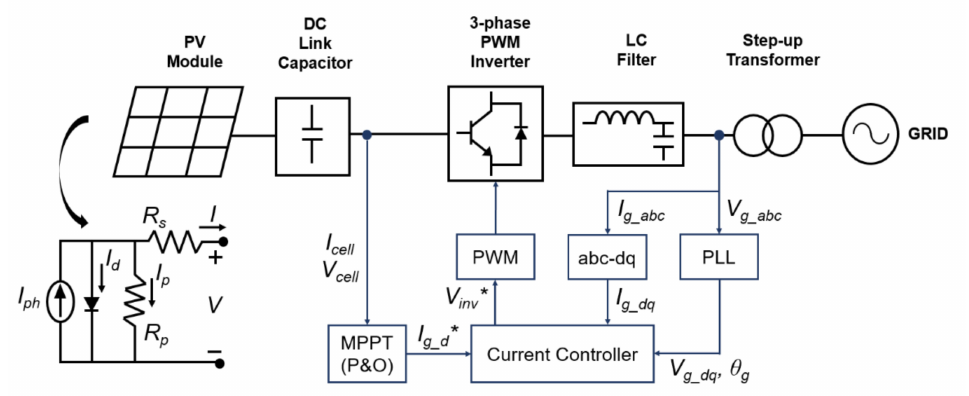
Figure 4. Simplified block diagram and control of photovoltaic (PV)